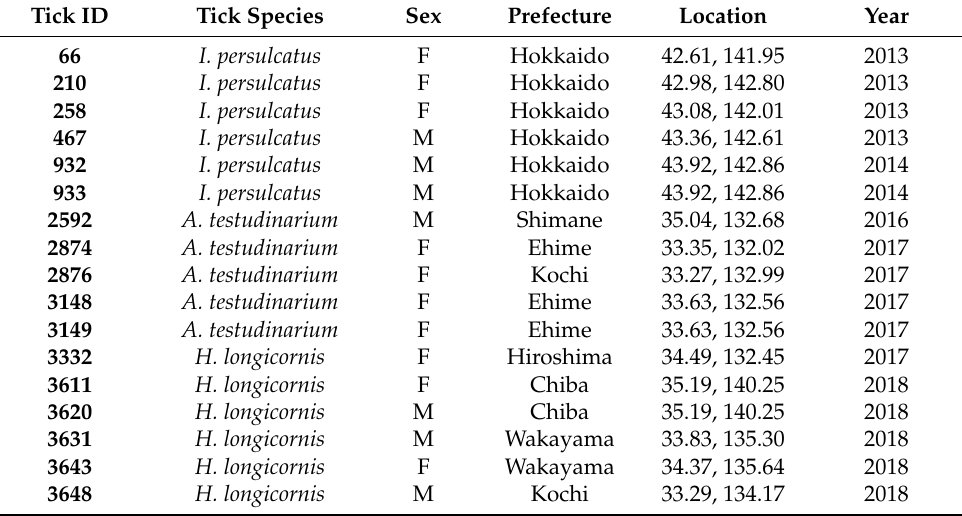
Table 1. Tick samples used in this study.